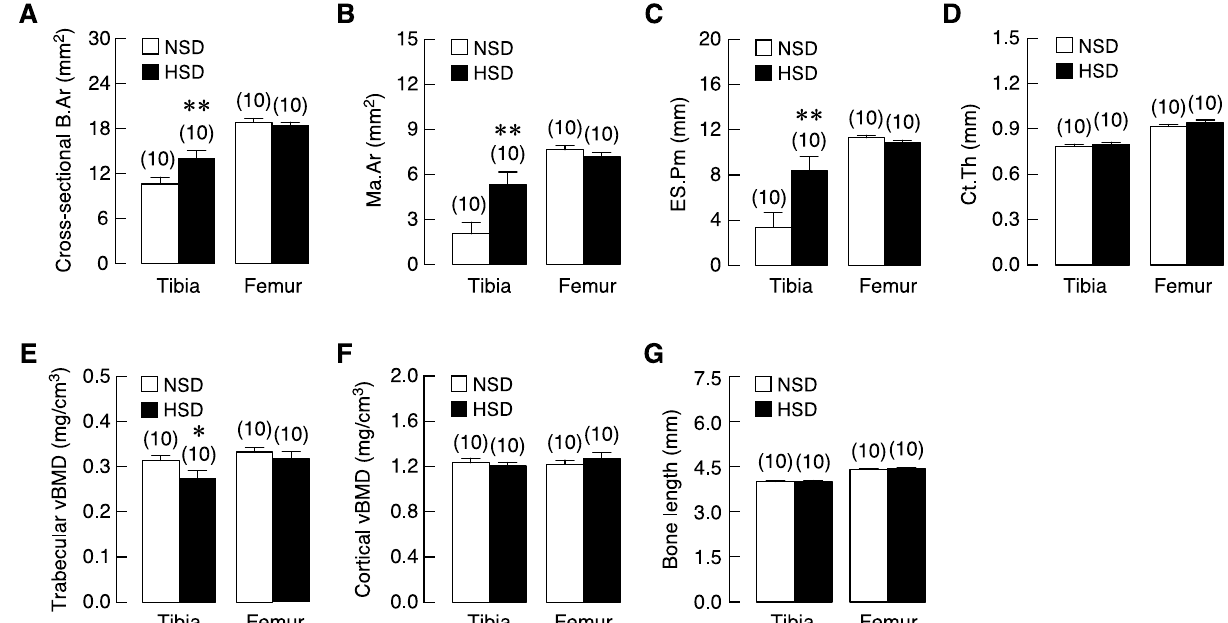
Figure 6. Microstructural parameters of tibiae and femurs of NSD and HSD. ( A ) Cross-sectional bone area; B.Ar, ( B ) medullary area; Ma.Ar, ( C ) endosteal perimeter; ES.Pm, ( D ) cortical thickness; Ct.Th, ( E ) trabecular volumetric BMD; vBMD, ( F ) cortical vBMD, and ( G ) bone length. Numbers of animals in each group are shown in parentheses. * P < 0.05, ** P < 0.01 compared to NSD.